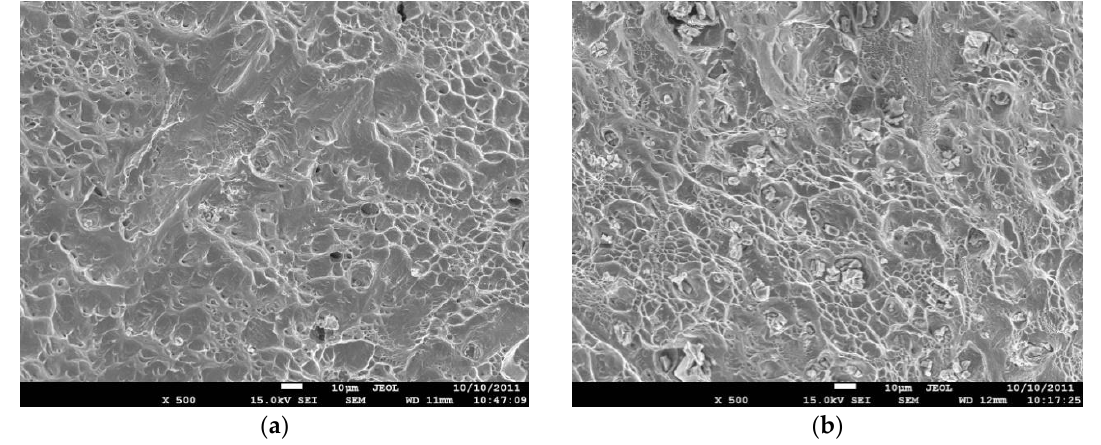
Figure 15. Final portions of fractured surfaces of VAT 36 ( a ) and VAT 32 ( b ) alloys, subjected to creep tests at 750 °C showing dimples of ductile fracture.